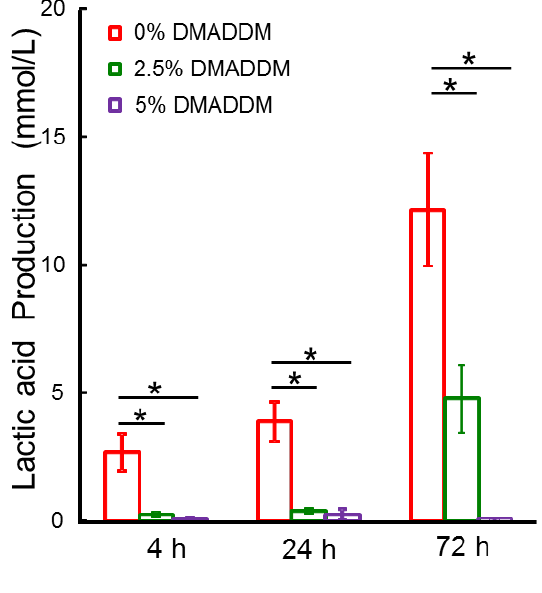
Figure 3. Lactic acid production by S. mutans biofilms adherent on the disks. Each value is mean ± SD; n = 6 ( * p <